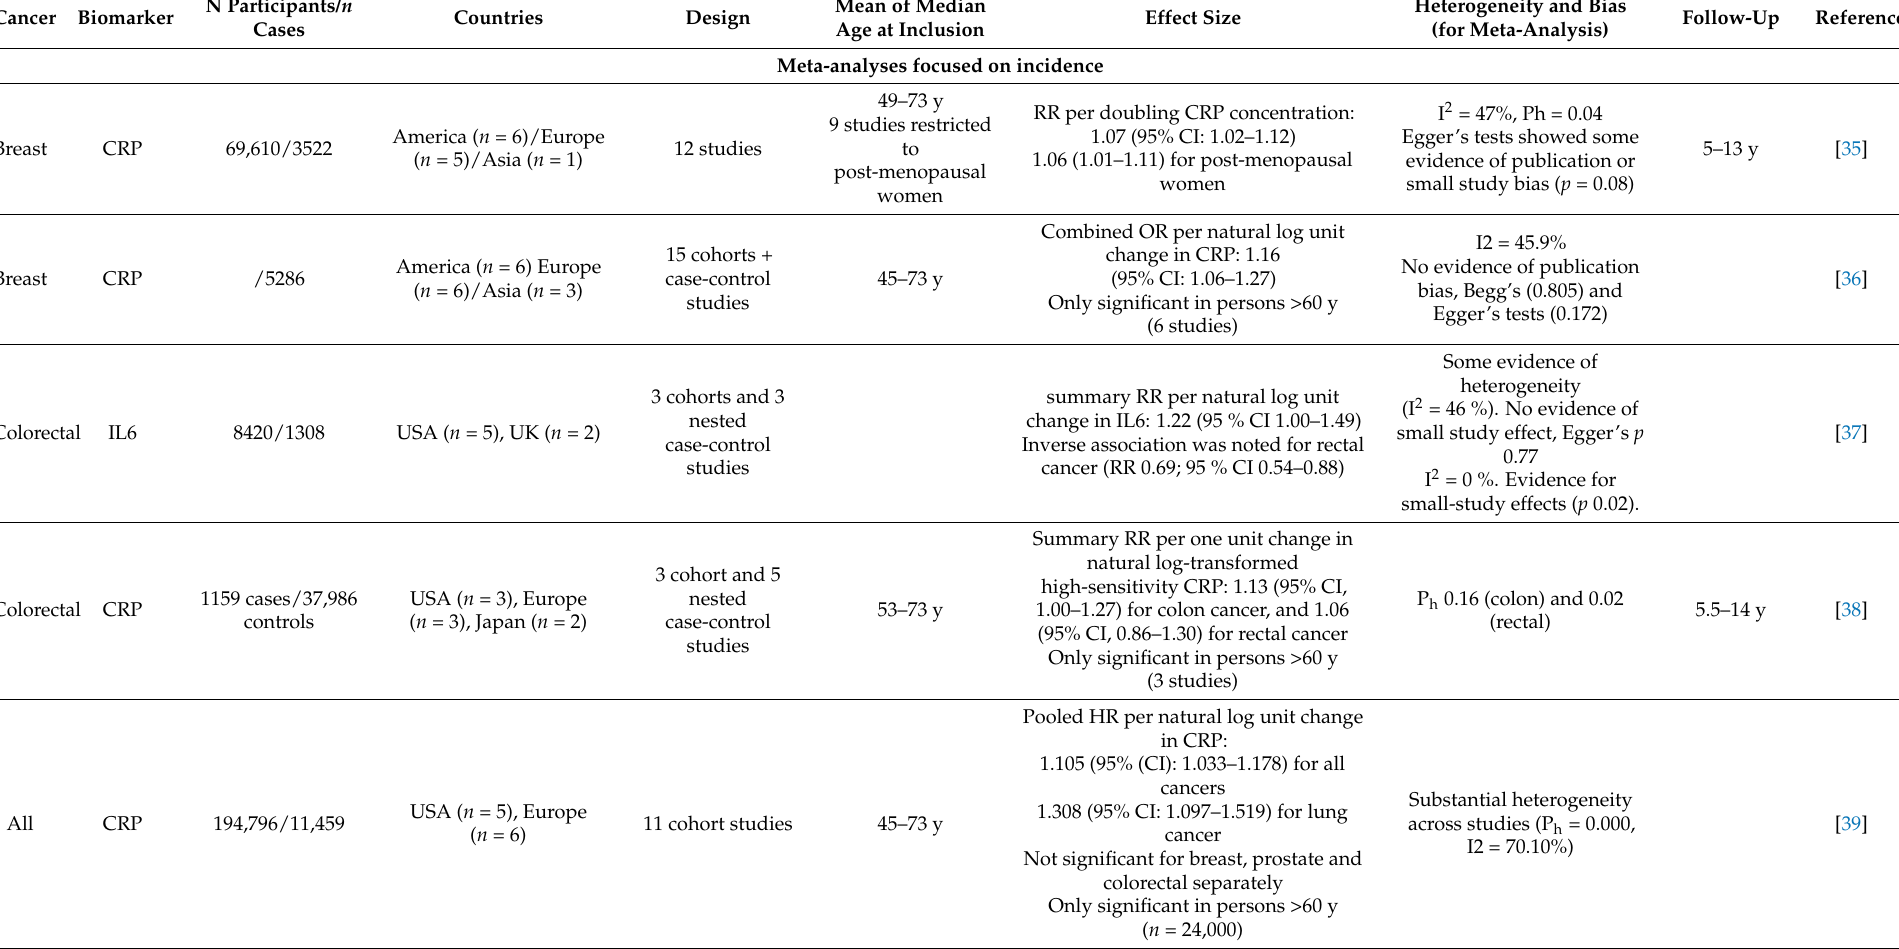
Table 1. Associations of blood inflammatory markers with cancer